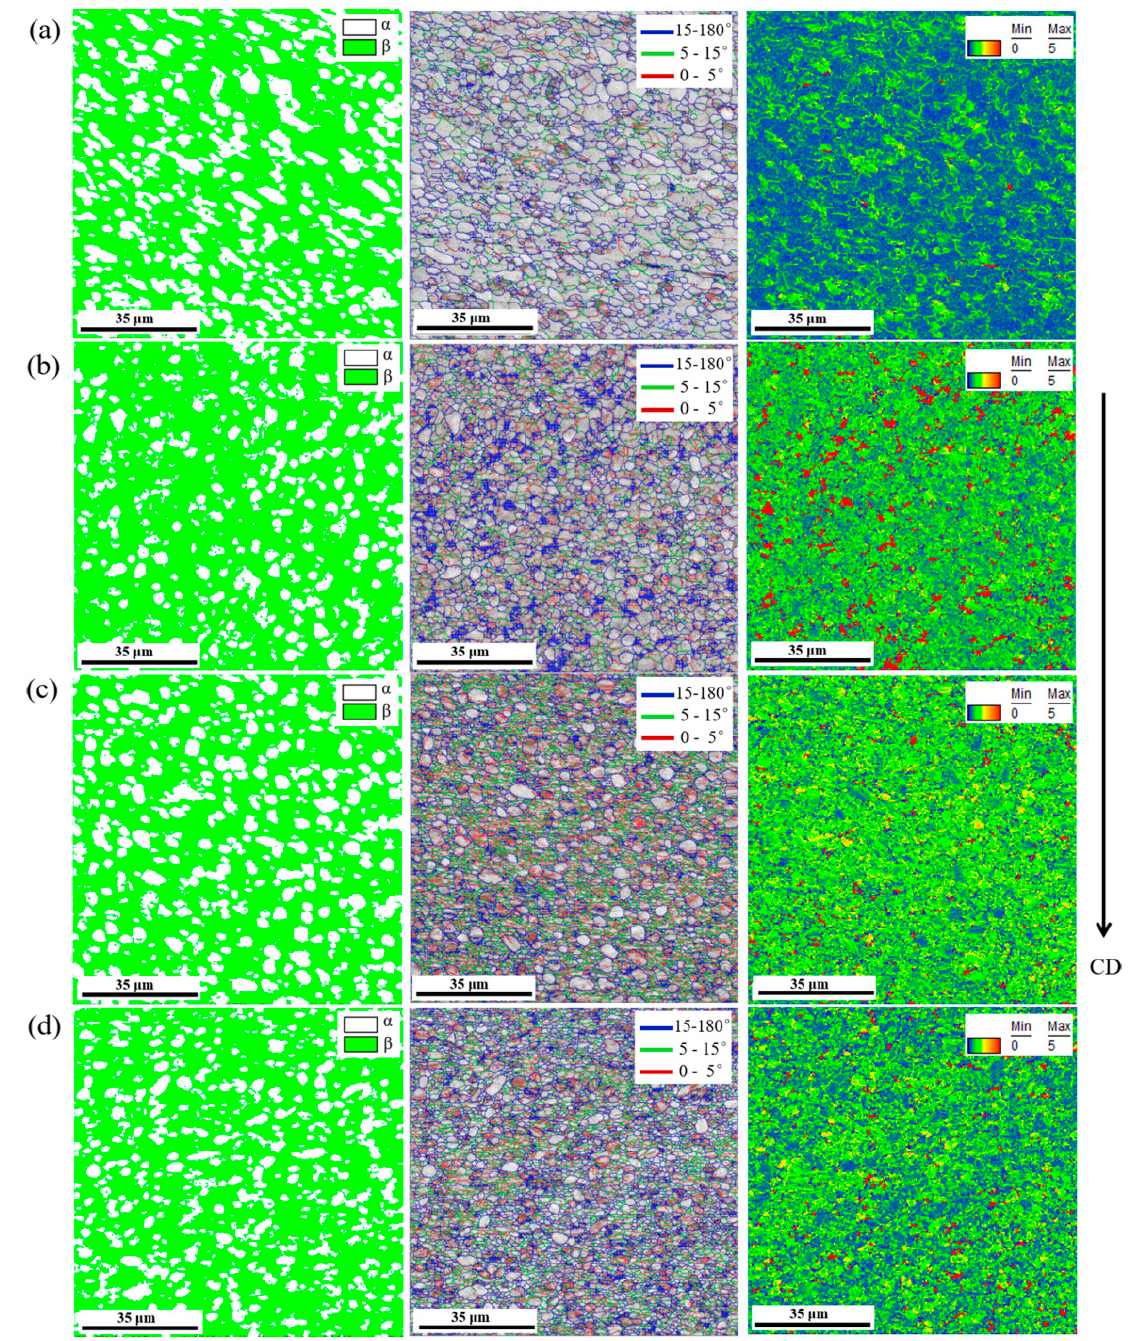
Figure 8. Phase distribution, grain boundary distribution and kernel average misorientation of Ti555211 alloy samples at 750 °C in the case of the various strain rates: ( a ) 0.005 s − 1 ; ( b ) 0.05 s − 1 ; ( c ) 0.5 s − 1 ; ( d ) 5 s − 1 .